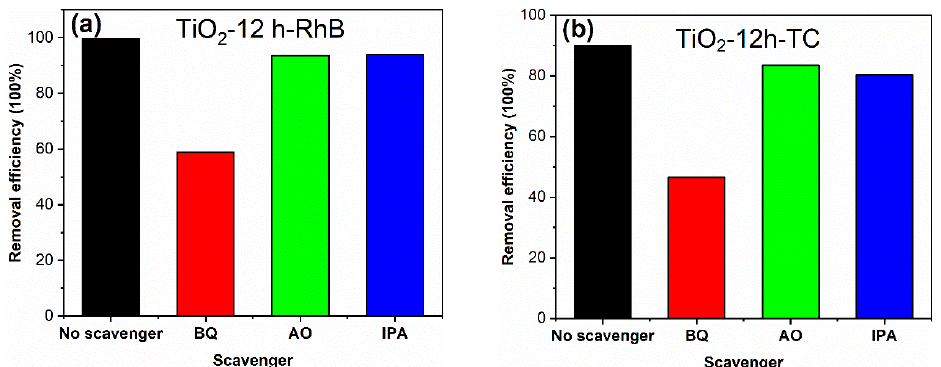
Figure 10. The degradation degrees of TiO 2 -12 h towards RhB ( a ) and TC ( b ) in the presence of different scavengers.